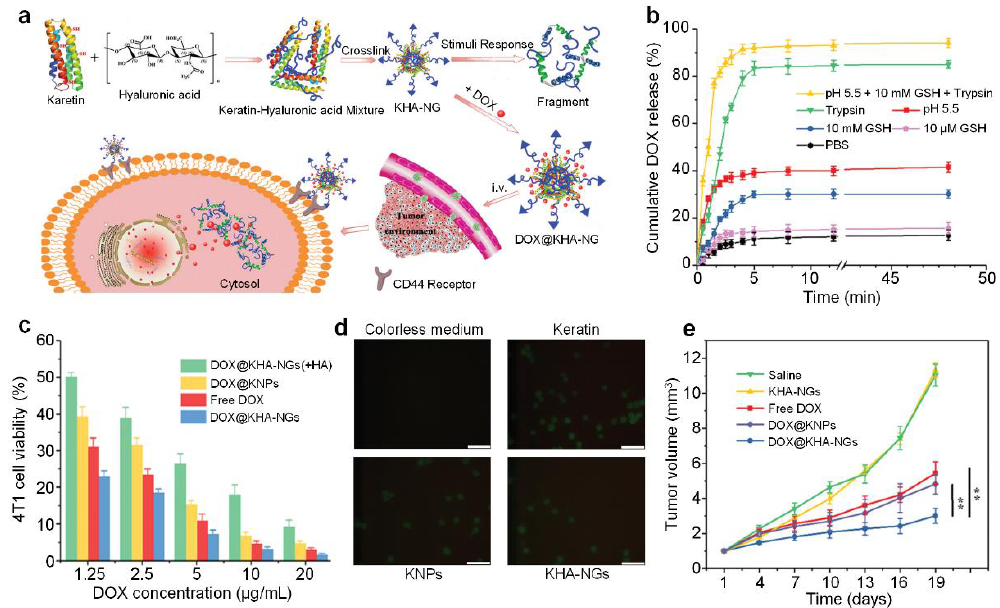
Figure 2. ( a ) Schematic illustration of preparation of KHA-NG and DOX@KHA-NG for cancer therapy. ( b ) DOX release profile of DOX@KHA-NGs under different conditions. ( c ) 4T1 Cell viability